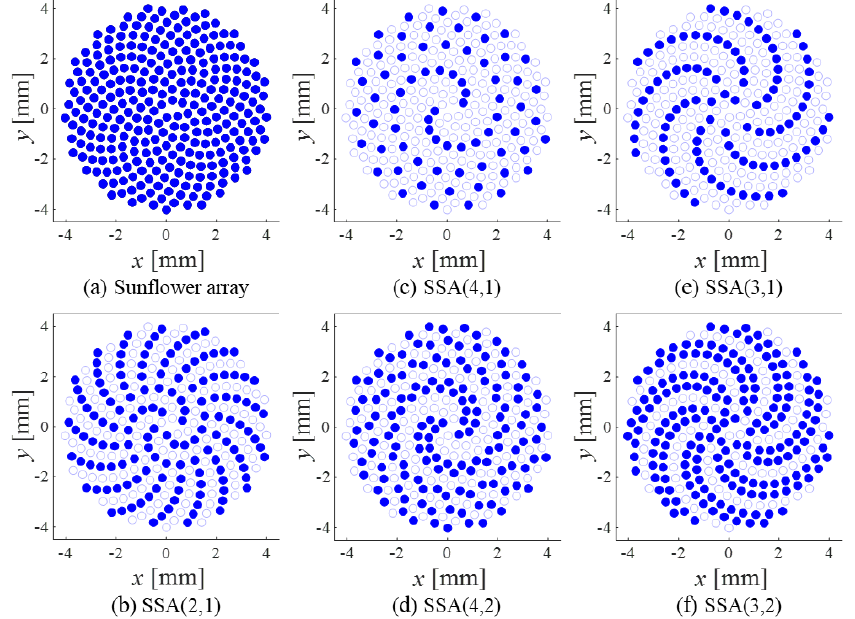
Figure 4. Examples of the spiral arrays: ( a ) the sunflower array and ( b – f ) the SSAs. Active elements are colored in blue.